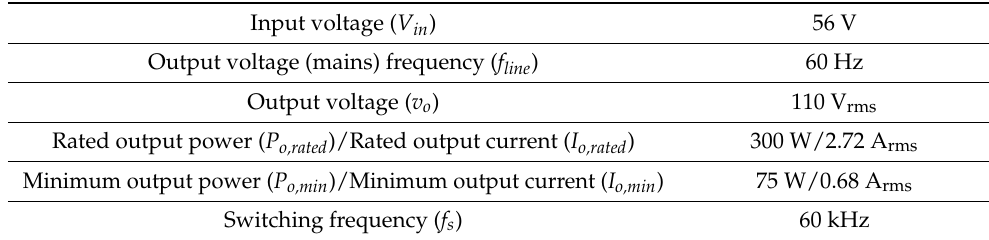
Table 2. Specifications of the 7-level DC-AC